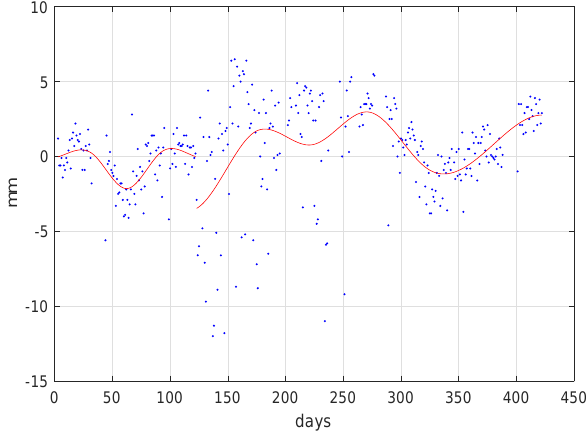
Figure 10. MDL index computed for the East antenna time series in the post-discontinuity period. East (red line), North (green line) and Up (blue line) components